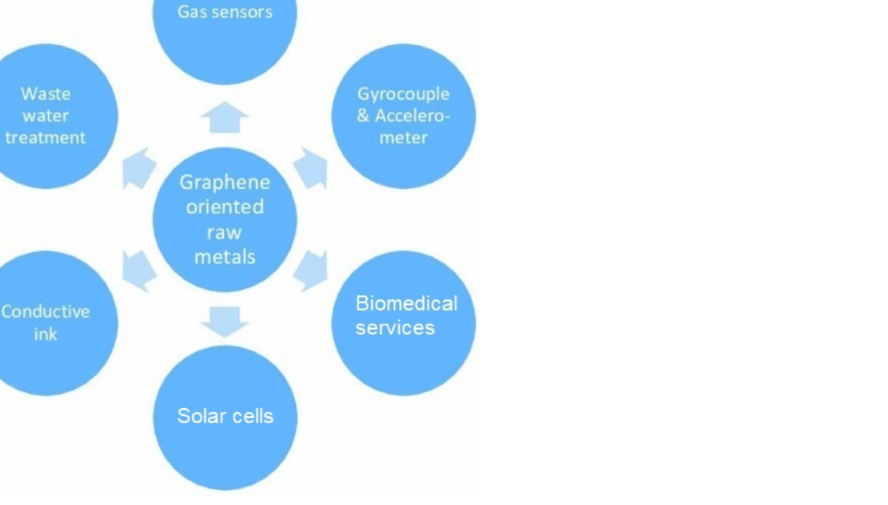
Figure 1. Overview of the use of graphene for different sensory applications [58]. Copyright 2019 AGH University of Science and